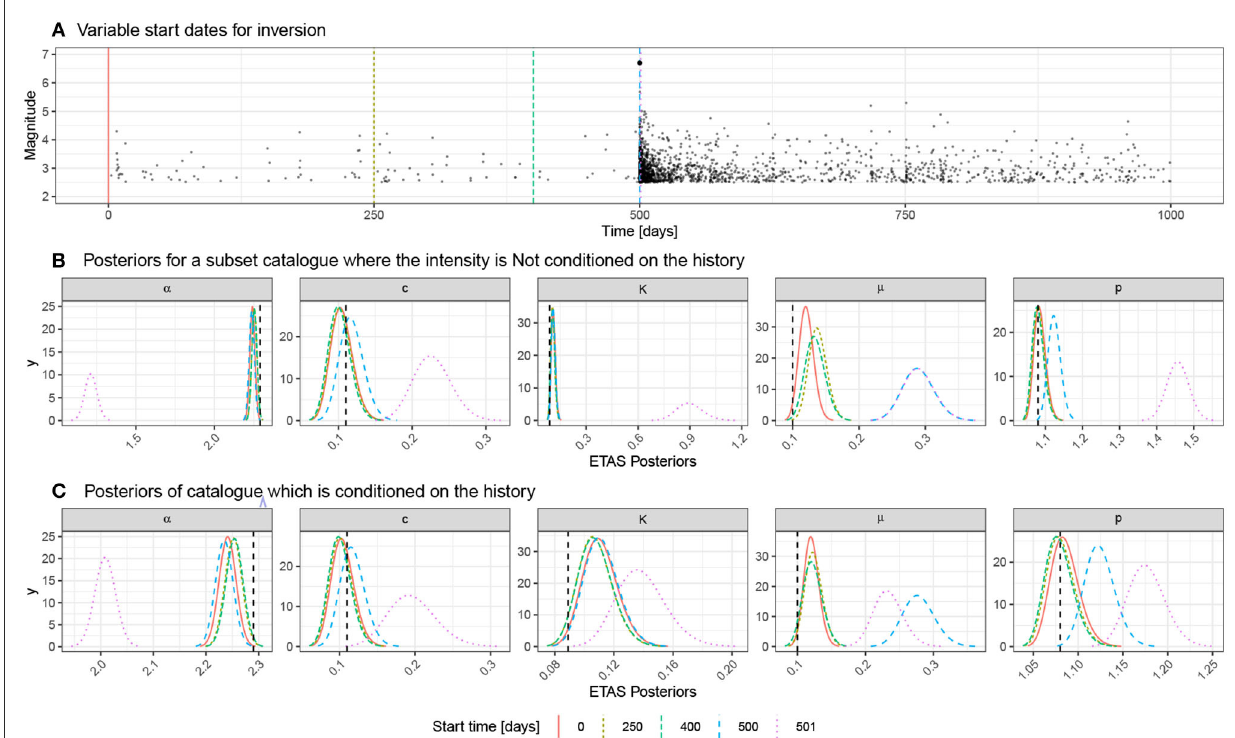
FIGURE9 (A) Catalog used to explore the concept of a representative sample and history conditioning. The baseline case on the top row has 500 days of background and an M6.7 event on day 500 with the sequence being recorded until day 1000. We vary the start date for the analysis to remove the first 250 days, 400 days, 500 days, and 501 days. In the last two cases, there is no background period remaining, and the large event is also prior to the catalog subset for the final case. (B) Posteriors of the ETAS parameters for each of the catalog subsets when we crop the subcatalog and do not use the preceding data to condition the model. (C) Rather than cropping out subcatalogs, we now retain the events preceding the start of the model domain and use these when estimating the triggering function. This produces a notably improved performance for the start date on day 501 when the large event is no longer within the model